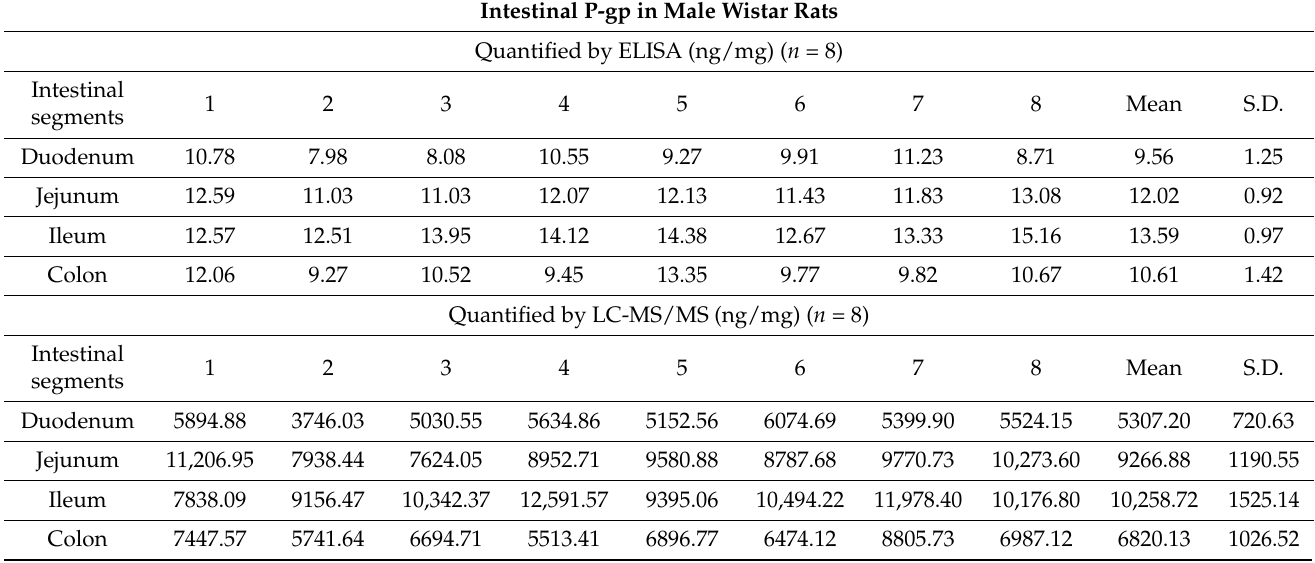
Table 2. P-glycoprotein expression in male and female Wistar rats quantified by enzyme-linked immunosorbent assay (ELISA) and liquid chromatography–tandem mass spectrometry (LC-MS/MS). Intestinal P-gp in Male Wistar Rats Quantified by ELISA (ng/mg) ( n =